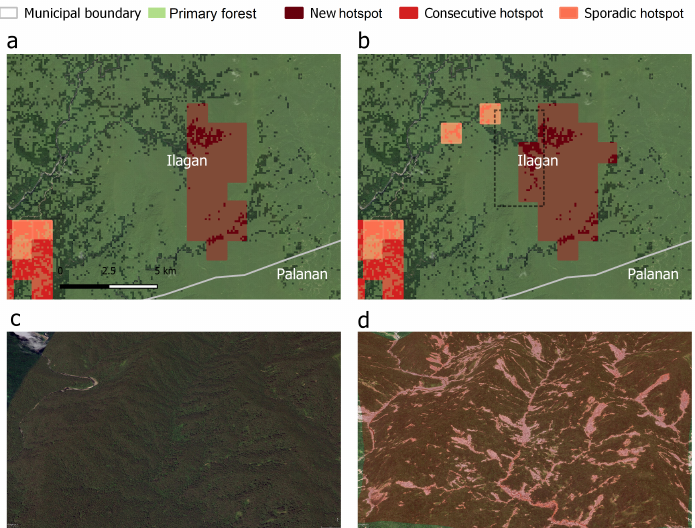
Figure 8. Another sample hotspot development this time using RADD alerts in 2020 within Sierra Madre (Ilagan, Isabela). After three quarters in ( a , b ), two typhoons have passed through this land area: May (typhoon Ambo ) and August (typhoon Helen ). See ( c , d ) for before (2017) and after (July 2020) actual images of the landscape to emphasize the deforestation from landslides (images from Google Earth